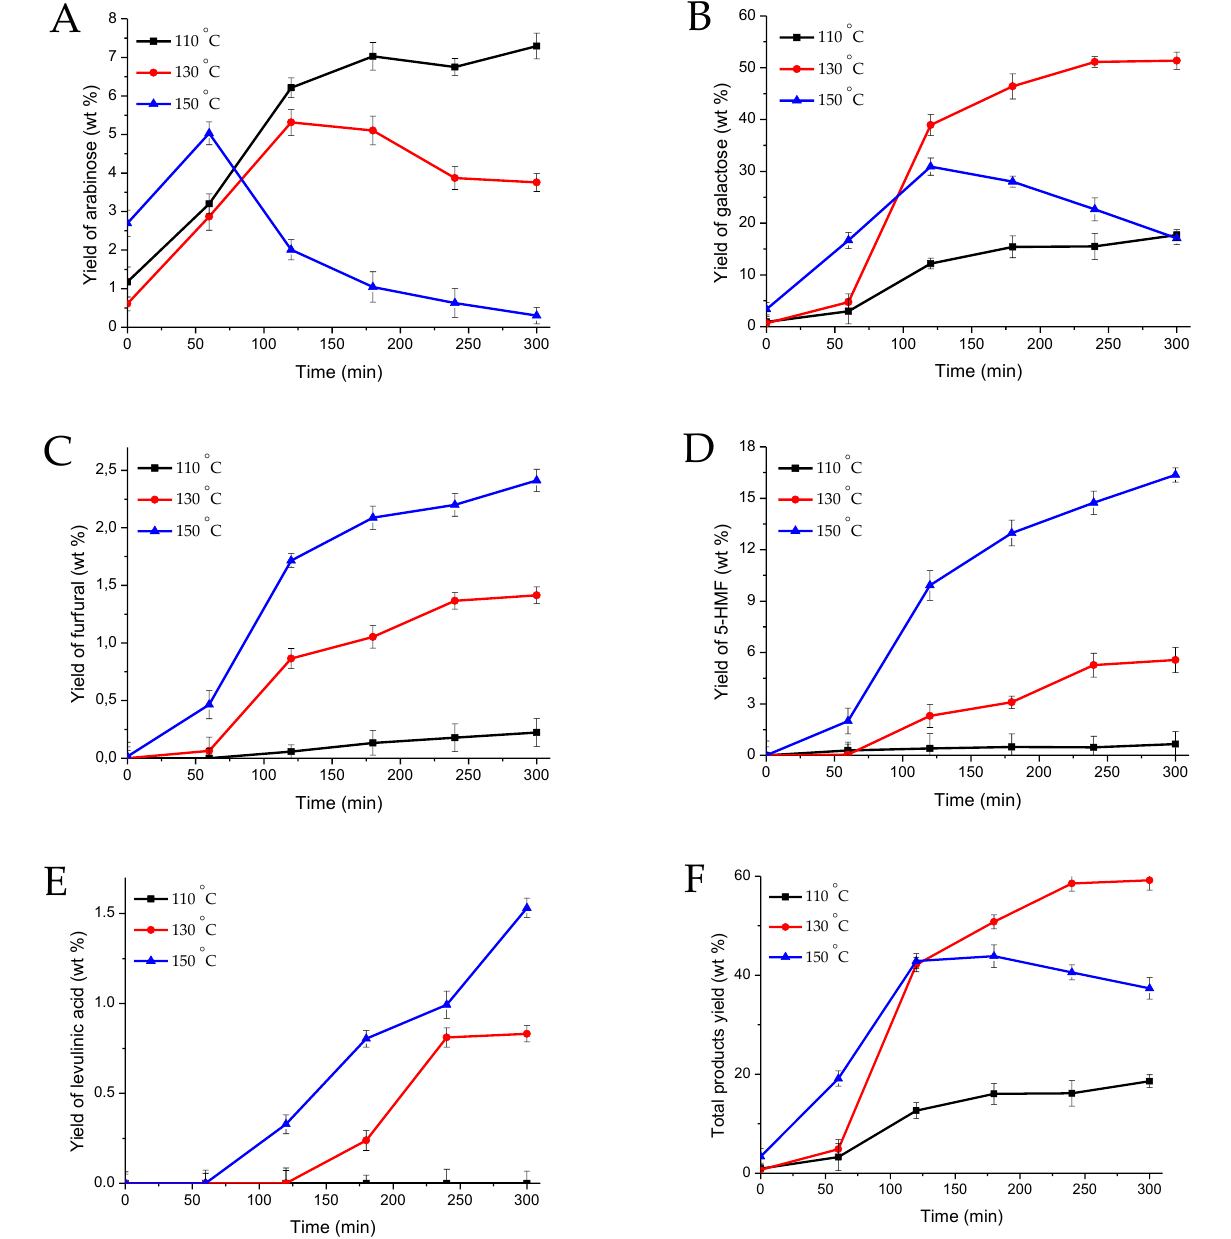
Figure 5. The kinetics of AG hydrolysis over 5%Zr-SBA-15 (n = 3–5). Yield of arabinose ( A ), galactose ( B ), furfural ( C ), 5-HMF ( D ), levulinic acid ( E ), the total yield of products ( F ). Table 4. The initial reaction rates W 0 (M · sec − 1 × 10 − 3 ) * of AG hydrolysis products formation and TOF.